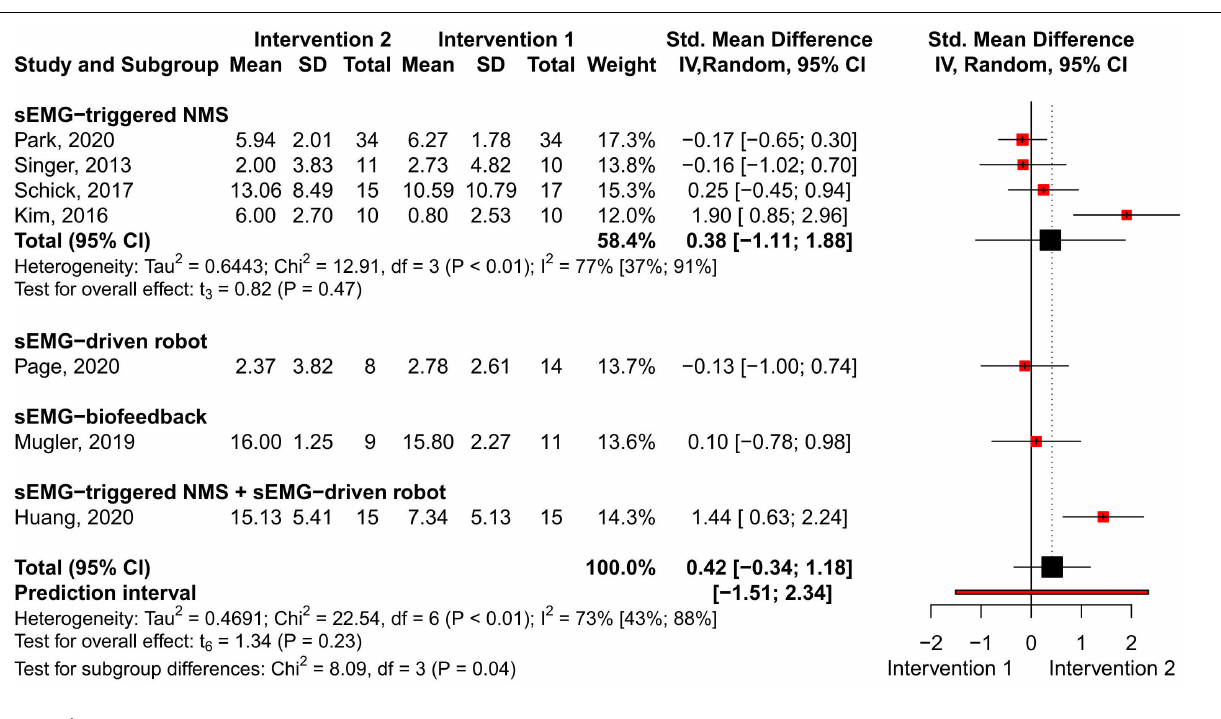
interventions might have a beneficial effect on improving arm and hand function as measured by FMA-UE, but this effect is not a non-sEMG